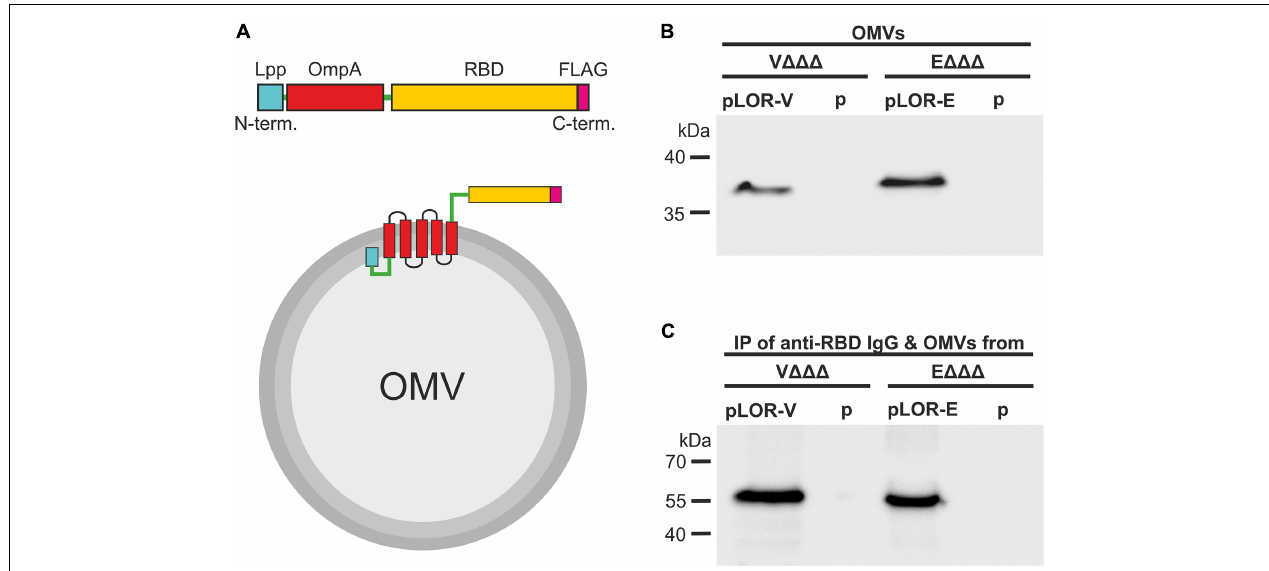
FIGURE 1 | Decoration of OMVs with RBD antigens via a Lpp-OmpA fusion strategy. (A) Schematic design of the Lpp-OmpA-RBD (LOR) fusion constructs (top) and expected localization in the OMVs (bottom). Relevant parts of the LOR include the Lpp fragment (light blue), linkers (green), OmpA fragment (red), theSARS-CoV-2 RBD fragment (yellow), and the FLAG-tag (pink). Panel (B) shown is a representative immunoblot detecting the LOR fusion protein in OMVs derived from V (cid:49)(cid:49)(cid:49) pLOR-V and V (cid:49)(cid:49)(cid:49) p, E (cid:49)(cid:49)(cid:49) pLOR-E, and E (cid:49)(cid:49)(cid:49) p. The commercially available anti-RBD antisera specifically detecting the SARS-CoV-2 Spike protein was used for this immunoblot. A Kang-stained SDS gel executed in parallel served as loading control ( Supplementary Figure 3 ). Panel (C) shown is a representative immunoblot detecting the heavy chain (approx. 55 kDa) of the commercially available anti-RBD antisera after an immunoprecipitation (IP) with OMVs derived from V (cid:49)(cid:49)(cid:49) pLOR-V and V (cid:49)(cid:49)(cid:49) p, E (cid:49)(cid:49)(cid:49) pLOR-E, and E (cid:49)(cid:49)(cid:49) p. OMVs of the respective strains were co-incubated with the anti-RBD antisera (IgG), subsequently pelleted and washed by centrifugation steps and finally separated by SDS-PAGE for immunoblot analyses (for details please see “Materials and Methods” section). The commercially available HRP-linked anti-rabbit antibody detecting the heavy chain of the anti-RBD IgG raised in rabbits was used for this immunoblot. A Kang-stained SDS gel executed in parallel served as loading control ( Supplementary Figure 4 ). (B,C) Molecular mass standards (Prestained Protein Marker Broad Range–New England Biolab) are indicated on the